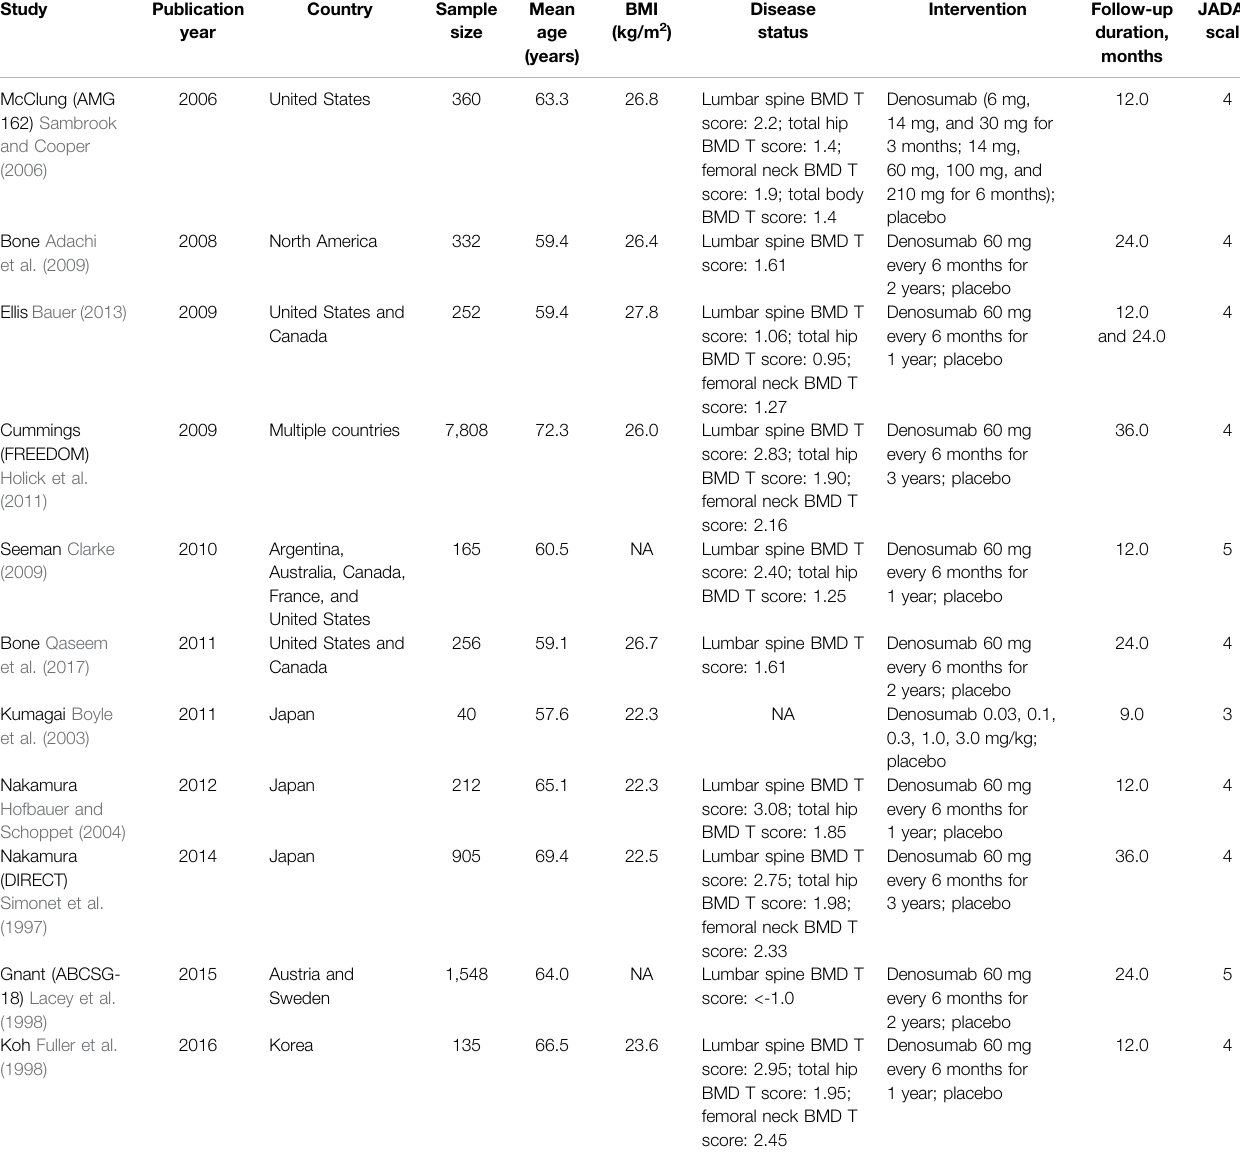
TABLE 1 | Baseline characteristics of studies included in the